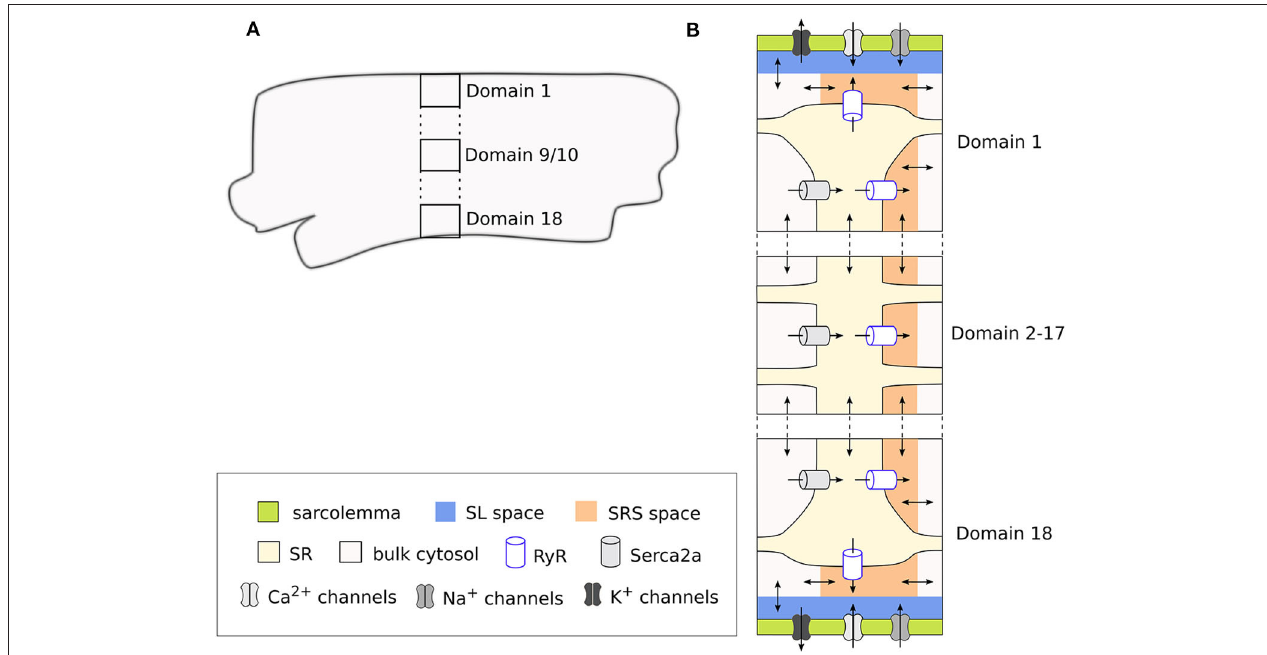
FIGURE 1 | Schematic representation of a segment of the rabbit CM model showing the discrete cell domains and different intracellular compartments. A single segment corresponds to the cross section of the CM (A) , and is composed of 18 domains. Here only 3 domains are represented for simplicity, with the vertical dots representing the omitted domains. The membrane domains (1 and 18) contain the sarcolemmal currents and Ca 2 + handling system, while the inner domains (2–17) contain only the Ca 2 + handling system (B) . Each membrane domain contains five different compartments: cytosolic space, sarcoplasmic reticulum (SR), sub-SR (SRS) space, and subsarcolemmal (SL) spaces, which together constitute the cleft space. Ca 2 + diffuses between the different compartments in the model, and between adjacent domains and segments. Because we use a deterministic RyR formulation, the model is symmetrical around the two central domains.